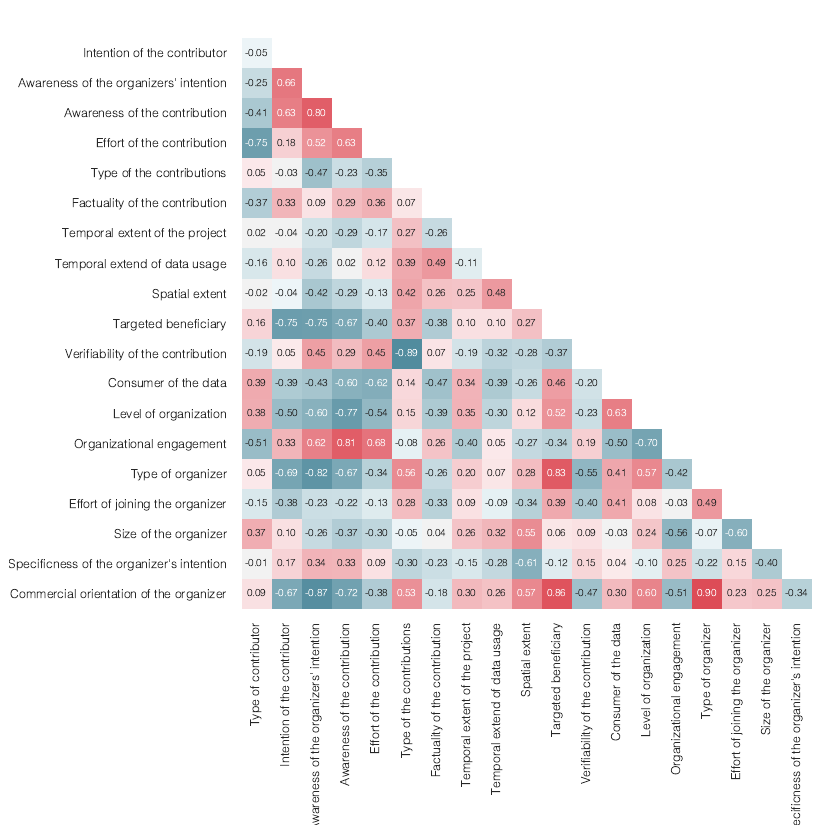
Figure 6. Correlation matrix of the dimensions for Geographical Shared Data Sources (SDSs), based on Kendall’s rank correlation coefficient.